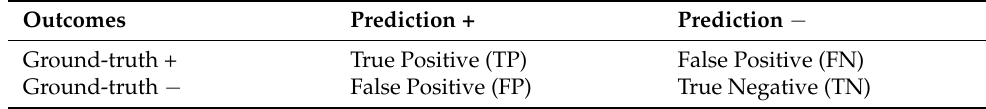
Table 2. Binary classification confusion